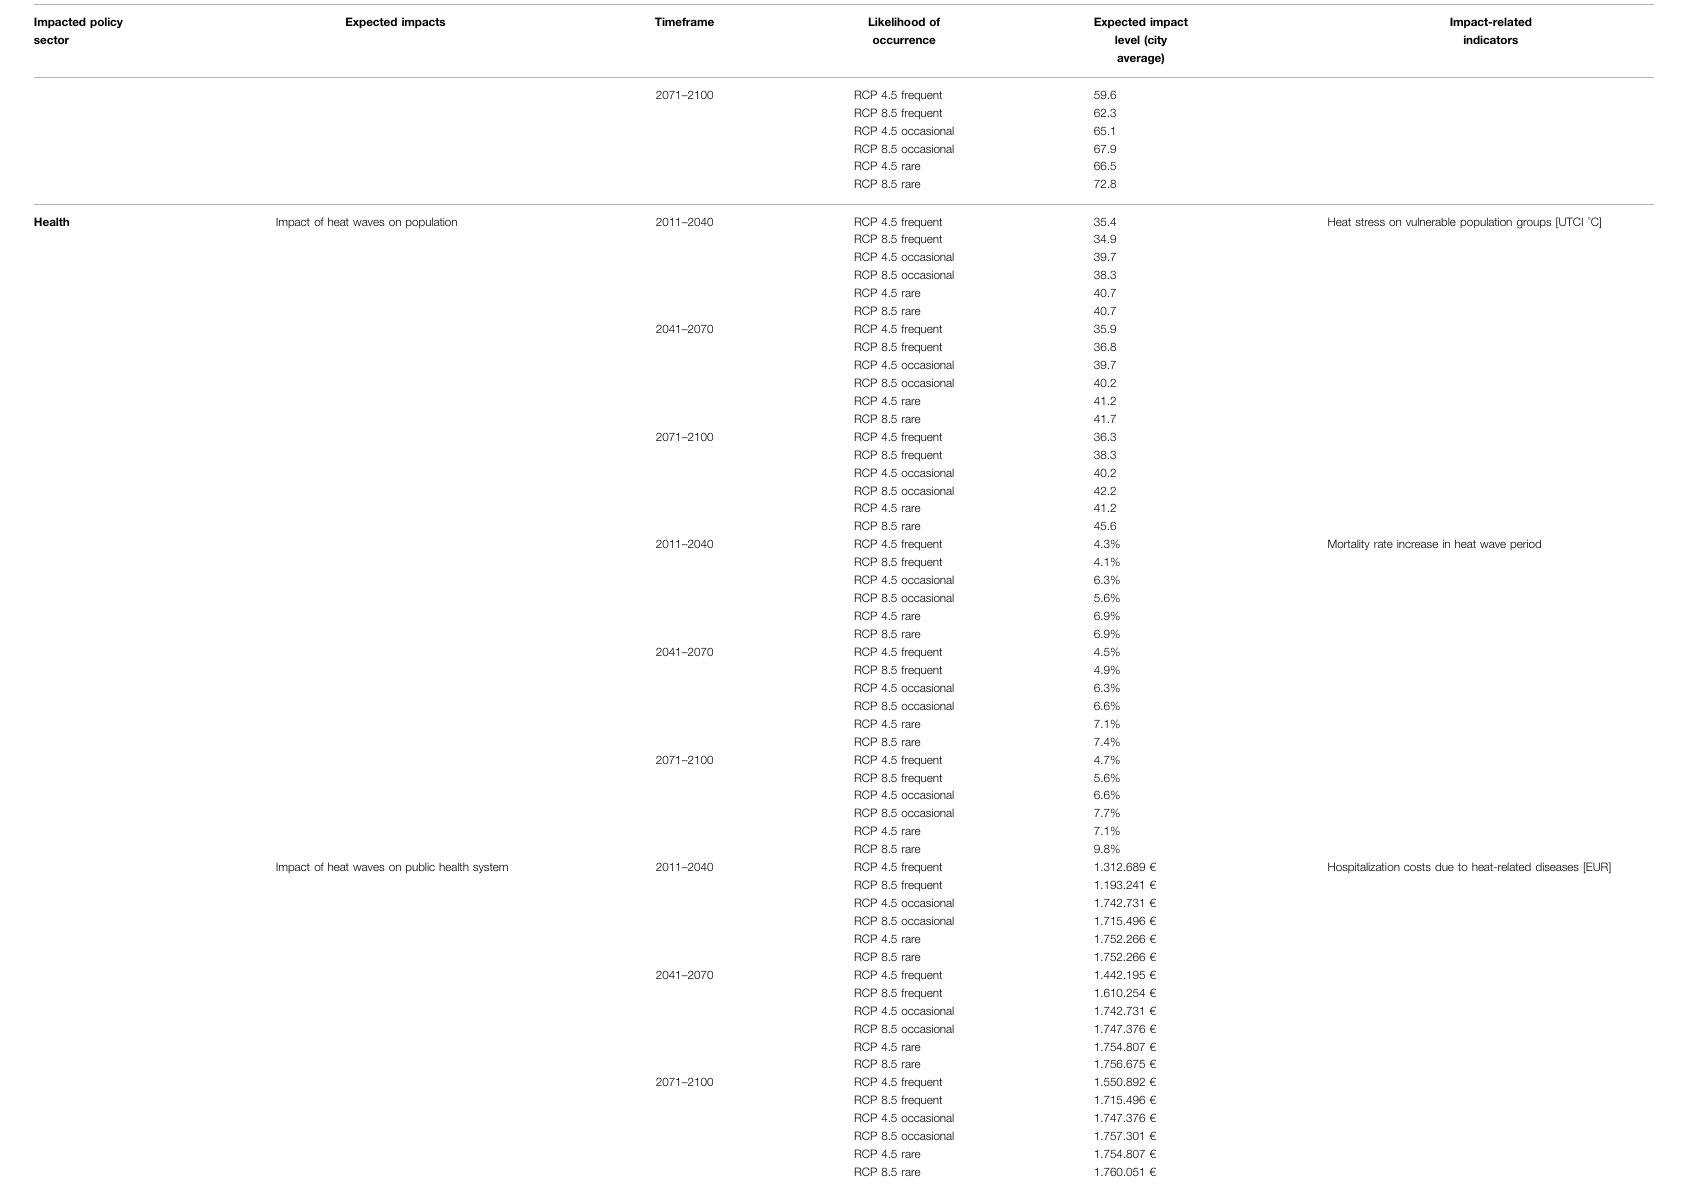
TABLE 1 | ( Continued ) Summary of impact indicators calculated for the Naples